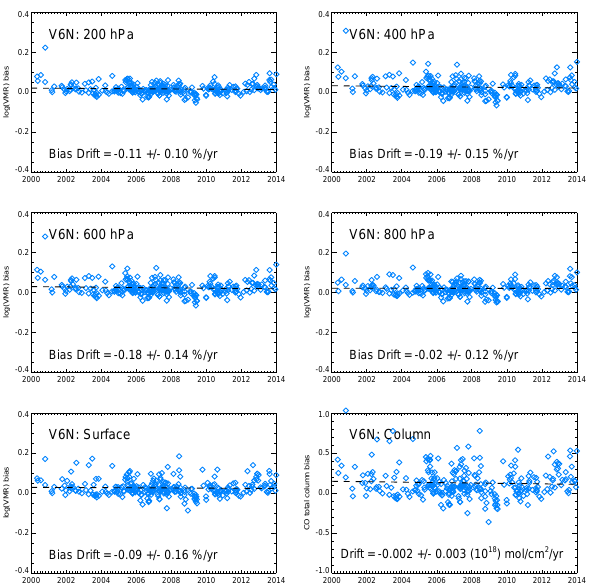
Figure 10. Latitudinal dependence of MOPITT V6 TIR-only (V6T) retrieval biases based on HIPPO profiles. Large black diamonds and error bars indicate mean biases and standard deviations within each 30 ◦ wide latitudinal